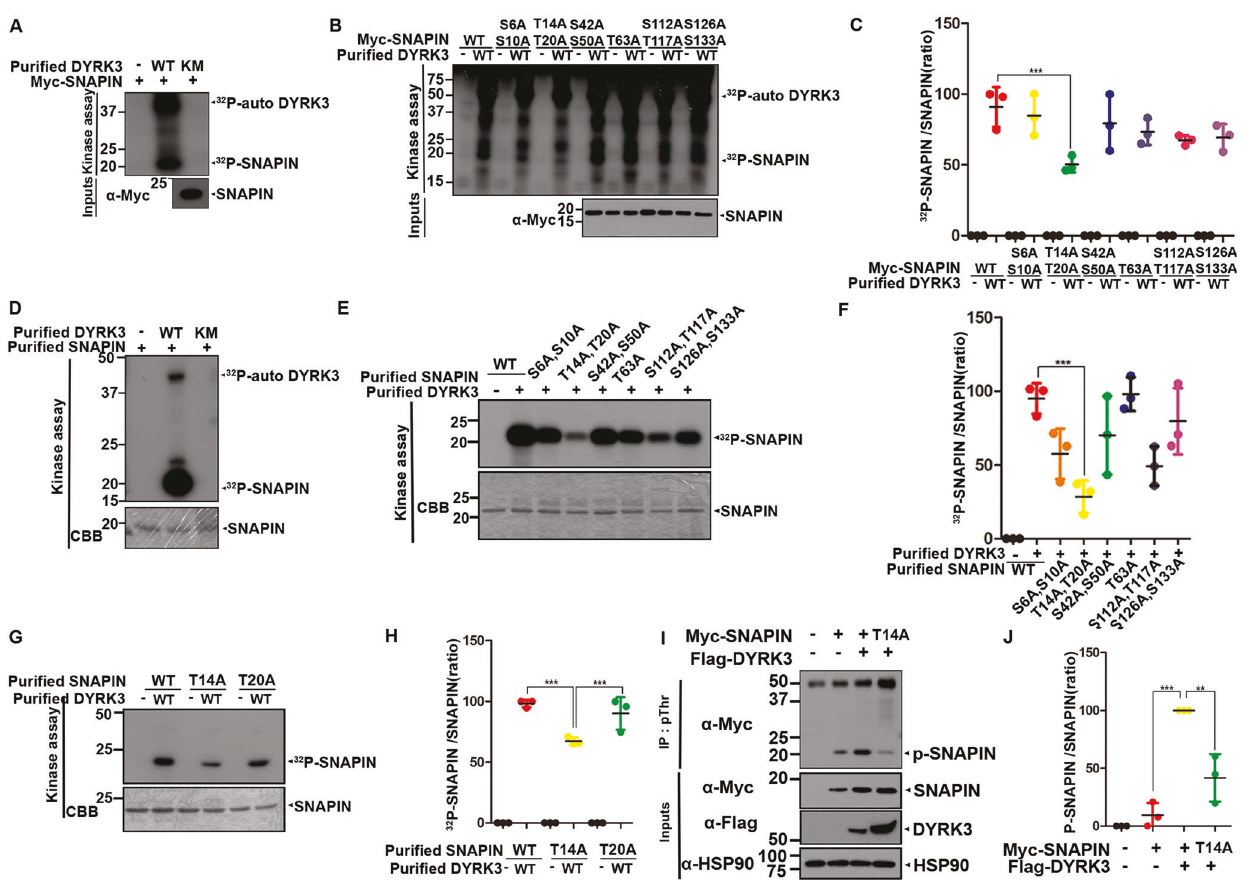
Fig. 2 DYRK3 phosphorylates SNAPIN at the threonine 14 residue. A After HEK293 cells were transfected for 24 h with a plasmid encoding Myc-SNAPIN, three equal cell lysates (~1000 μ g of protein) were immunoprecipitated with anti-Myc antibody. Where speci fi ed, the samples were mixed with bacterially expressed wild-type DYRK3 (DYRK3-WT) or its kinase-inactive mutant (DYRK3-KM), incubated for 30 min at 30 °C with kinase buffer and [ γ - 32 P]ATP, resolved by SDS-PAGE, and analyzed by autoradiography. Proper expression of transiently expressed SNAPIN in cell extracts was veri fi ed by immunoblotting with anti-Myc antibody (Input). B HEK293 cells were transfected for 24 h with a plasmid encoding Myc-SNAPIN-WT or one of the SNAPIN point-mutants, including SNAPIN-S6/S10A, SNAPIN-T14/T20A, SNAPIN-S42/S50A, SNAPIN- T63A, SNAPIN-S112/T117A, and SNAPIN-S126/S133A, followed by immunoprecipitation with anti-Myc antibody. The anti-Myc immunocom- plexes as a substrate were mixed with bacterially expressed DYRK3-WT, incubated for 30 min at 30 °C with kinase buffer and [ γ - 32 P]ATP, resolved by SDS-PAGE, and analyzed by autoradiography. C Quanti fi cation of expression levels from the blots in B . Data represent the mean ± standard deviation of three independent experiments (*** p < 0.001). Statistical analyses were performed using the IBM SPSS Statistics software (version 23.0). D , E In vitro kinase assays mixing the bacterially expressed DYRK3-WT, DYRK3-KM, SNAPIN-WT D , and one of several SNAPIN- point mutants E alone or in combination with kinase buffer and [ γ - 32 P]ATP, incubated for 30 min at 30 °C, resolved by SDS-PAGE, and analyzed by autoradiography. The recombinant SNAPIN protein bands were visualized with Coomassie blue staining (CBB). F Quanti fi cation of the bands in E . All data represent the mean ± standard deviation of three independent experiments (*** p < 0.001). G In vitro kinase reaction products were prepared by mixing bacterially expressed DYRK3-WT, SNAPIN-T14A, or SNAPIN-T20A alone or in combination, incubated for 30 min at 30 °C with kinase buffer and [ γ - 32 P]ATP, resolved by SDS-PAGE, and analyzed by autoradiography. The recombinant SNAPIN bands were visualized with CBB. H Quanti fi cation of the bands in G . All data represent the mean ± standard deviation of three independent experiments (*** p < 0.001). I HEK293 cells were transfected for 24 h with a plasmid encoding Myc-SNAPIN WT, Myc-SNAPIN-T14A, or Flag- DYRK3 alone or in combination. Cell lysates were immunoprecipitated with anti-pThr antibody, followed by immunoblotting with anti-Myc antibody. J Quanti fi cation of the bands in I . All data represent the mean ± standard deviation of three independent experiments (** p < 0.01, *** p <